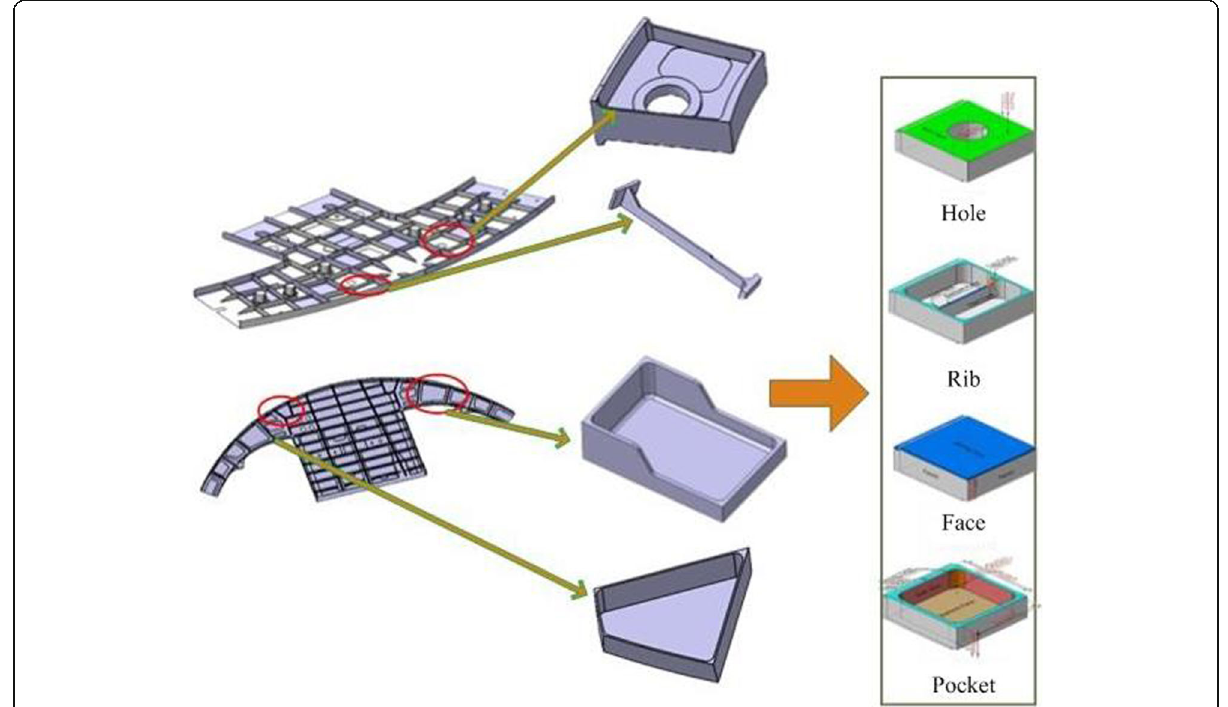
Fig. 3 Typical machining features of thin-walled aircraft structural